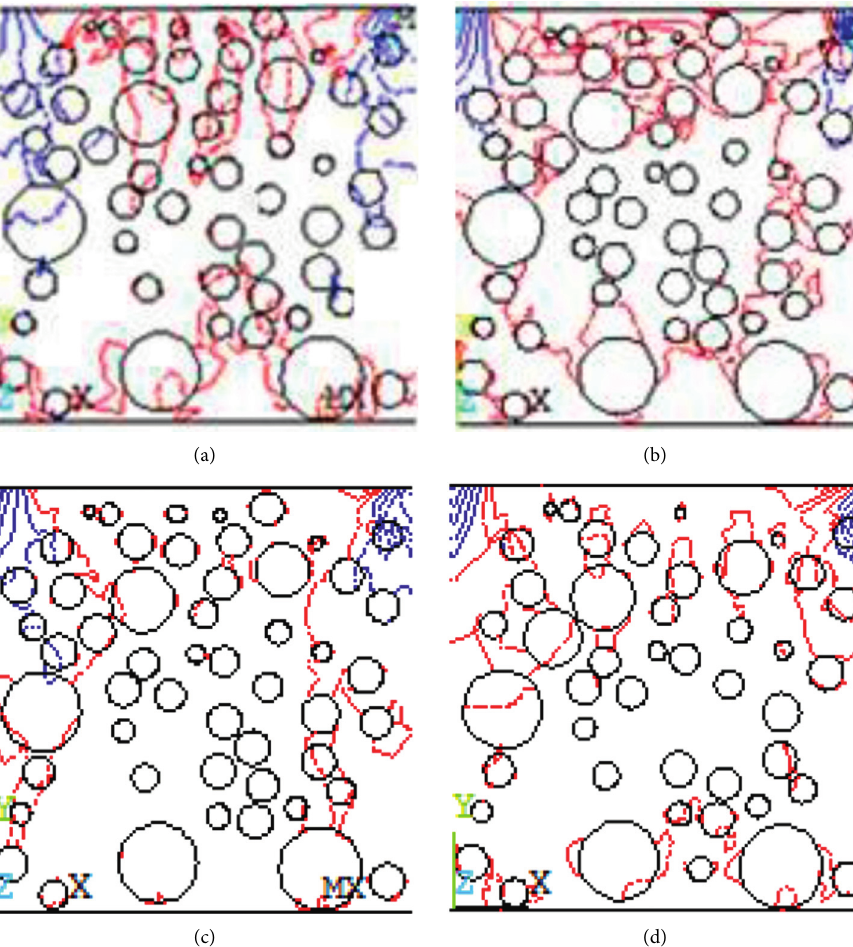
Figure 6: Stress contour of the concrete with cobbles at different gradations: (a) 20%: 80%; (b) 30%: 70%; (c) 40% :60%; (d) 50%: 50%.